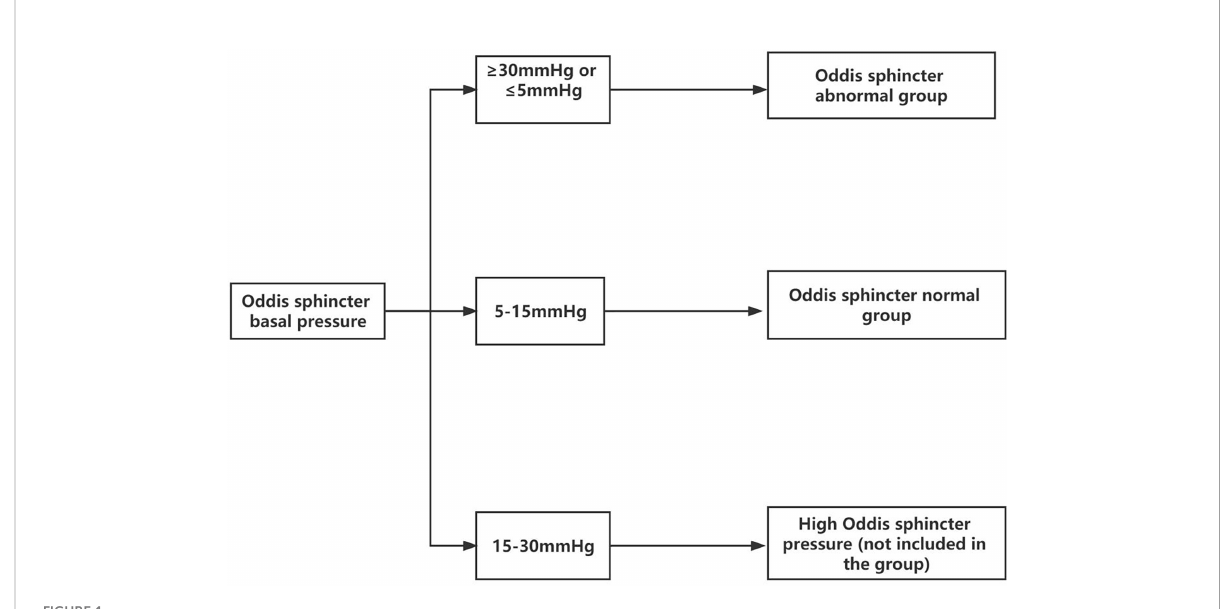
FIGURE 1 Grouping according to the basal pressure in the sphincter of